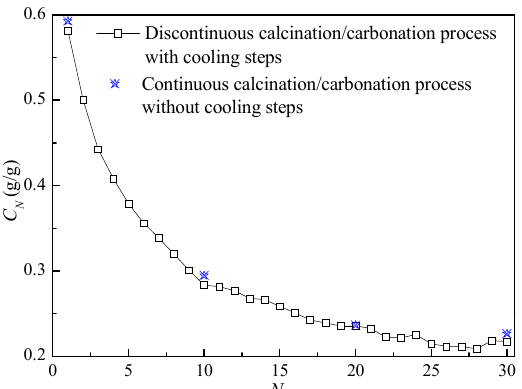
Figure 2. Preliminary experiments on calcination/carbonation processes with/without cooling steps (carbide slag as the sample, carbonation in 15% CO 2 /N 2 at 700 °C for 20 min, calcination in 100% N 2 at 850 °C).